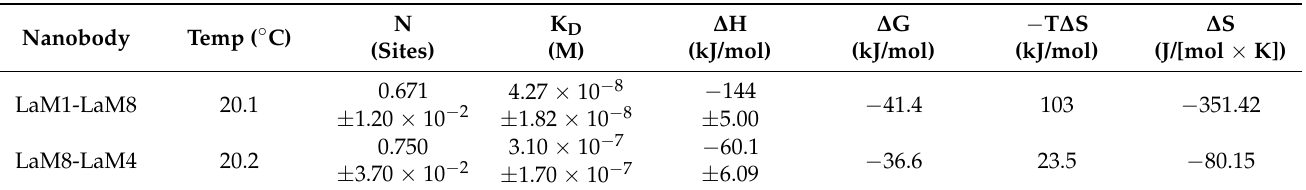
Table 5. The binding thermodynamic parameters between the multivalent nanobodies to mCherry by isothermal titration